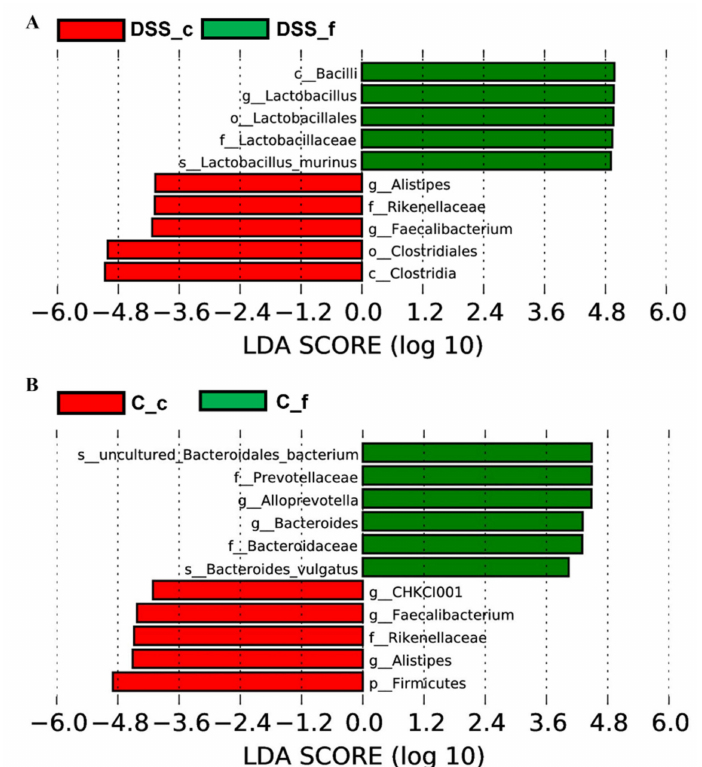
Figure 13. Histogram of LDA scores of caecal (_c) and faecal (_f) samples in DSS ( A ) and control group ( B ). Faecal and caecal samples were collected on the day of sacrifice. p, phylum; c, class; o, order; f, family; g, genus and s, species. DSS, induced colitis; C, healthy